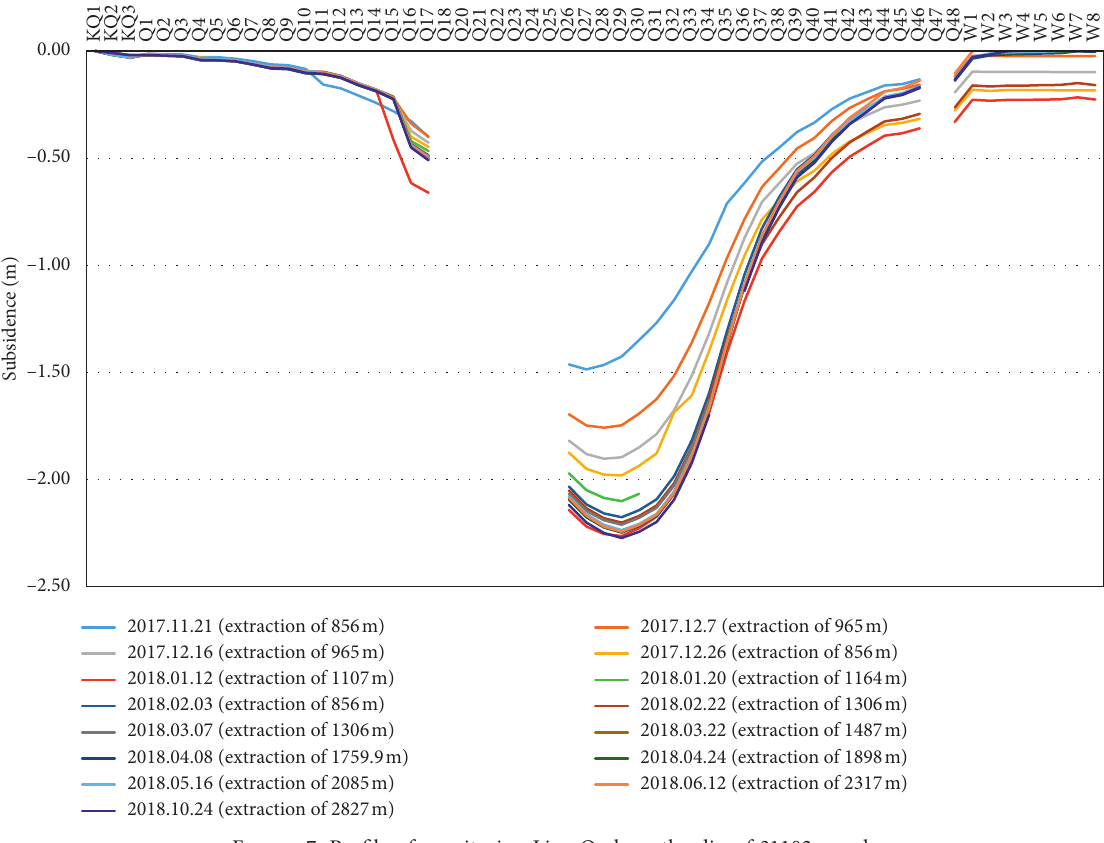
Figure 7: Profile of monitoring Line Q along the dip of 31102 panel.